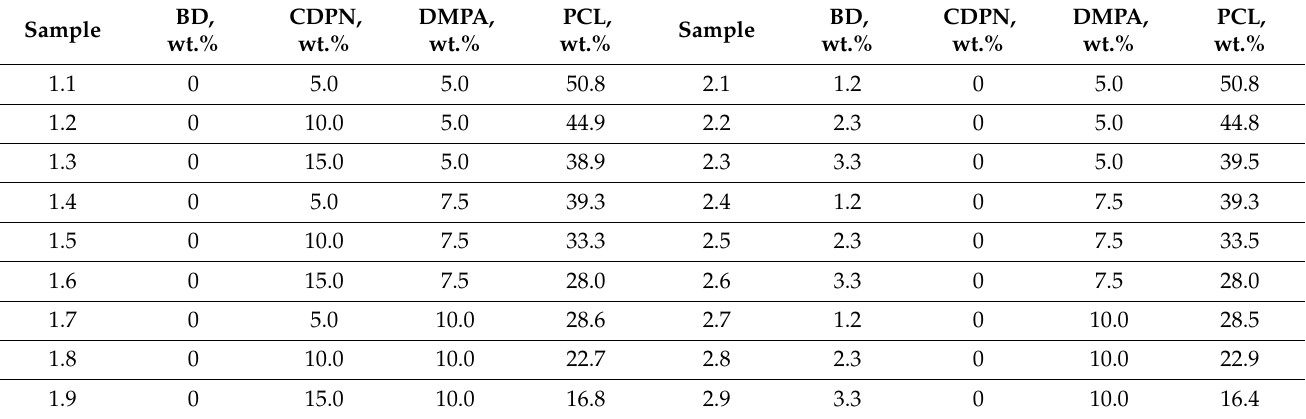
Table 2. Composition of WPU dispersions.